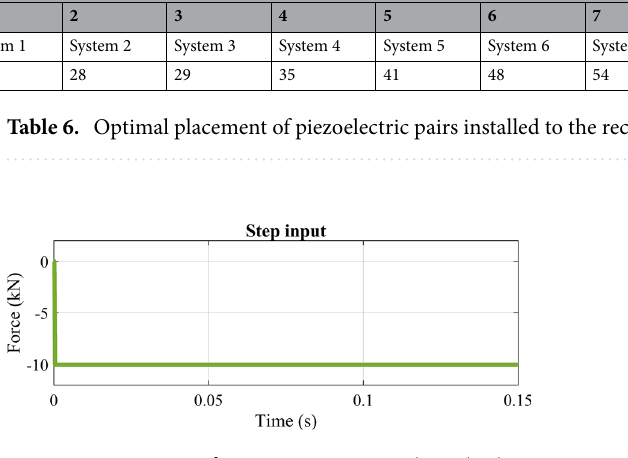
Figure 14. Step input force in t = 0.0002s at (x, y, z) = (0, 0.269375 m, 0.03